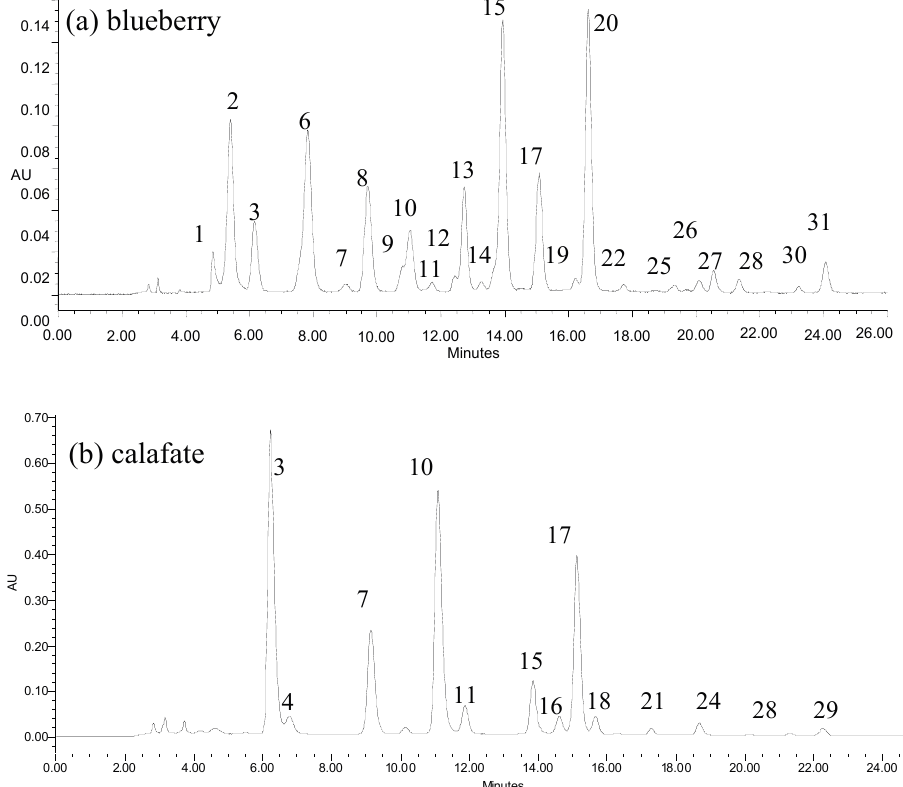
Figure 2. HPLC-PDA chromatograms of six berries from the VIII region of Chile. ( a ) Vaccinium corymbosum , ( b ) Berberis microphylla , ( c ) Ugni molinae , ( d ) Luma chequén , ( e ) Luma apiculata , and ( f ) Amomyrtus meli monitored at 520 nm. Peaks numbers refer to those indicated in Table